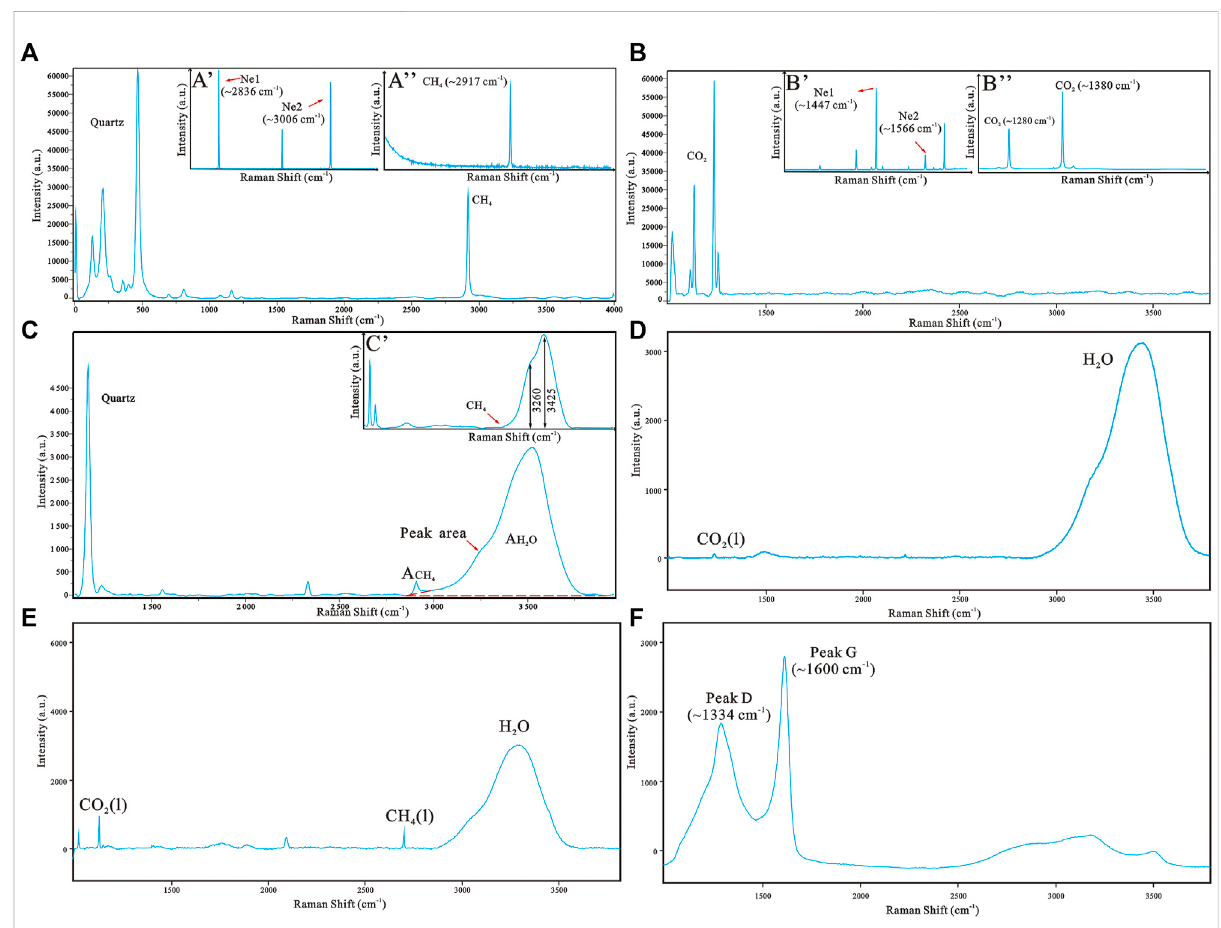
FIGURE 6 Classical Raman spectra of CH 4 - and CO 2 -bearing fl uid inclusions: (A) spectra of the pure CH 4 component collected using the 300 gr.mm − 1 gratinginquartz[theCH 4 symmetricstretchingband( v 1 )peakwascollected usingthe1,800 gr.mm − 1 gratingwith aNelamp]; (B) spectra ofthepure CO 2 componentcollectedusingthe300 gr.mm − 1 gratinginquartz[theCO 2 Fermidoublepeakwascollectedusingthe1,800 gr.mm − 1 gratingwitha Ne lamp]; (C) spectra of CH 4 – H 2 O – NaCl components collected using the 300 gr.mm − 1 grating obtained in the homogeneous state [(C ′ ) is the spectraoftheliquidpartatroomtemperature]; (D) spectraofCO 2 – H 2 O – NaClcomponentscollectedusingthe300 gr.mm − 1 gratingobtainedinthe homogeneous state; (E) spectra of CH 4 – CO 2 – H 2 O – NaCl components collected using the 300 gr.mm − 1 grating obtained in the